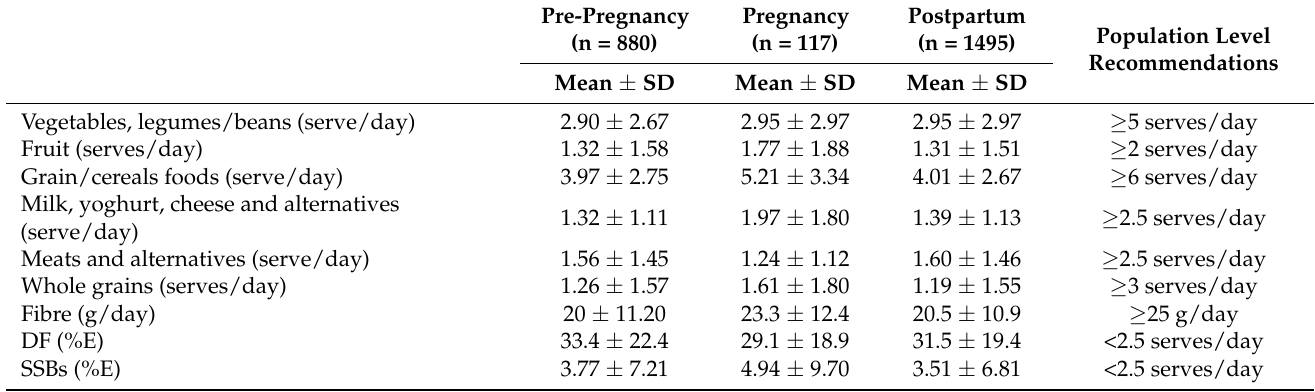
Table 2. Core food groups and energy from discretionary foods in women across reproductive life stages.